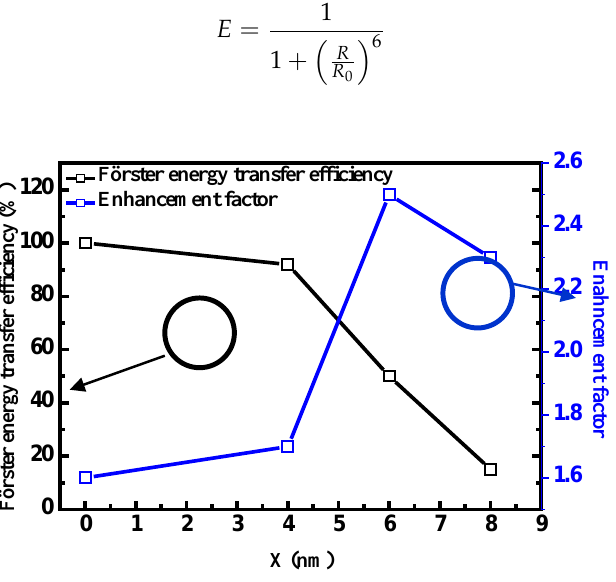
Figure 3. ( a ) Current density-voltage curves; ( b ) luminance-voltage curves in log scale; and ( c ) current efficiencies curves of devices without GNPs and with different spacing distances. Inset of ( b ) shows the power efficiency-voltage characteristics of device.